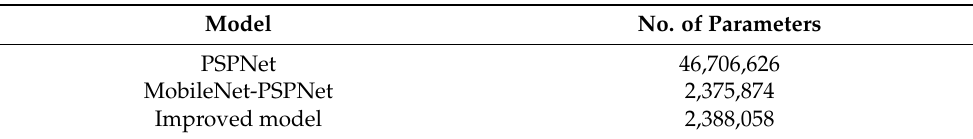
Table 5. Number of parameters for different models.